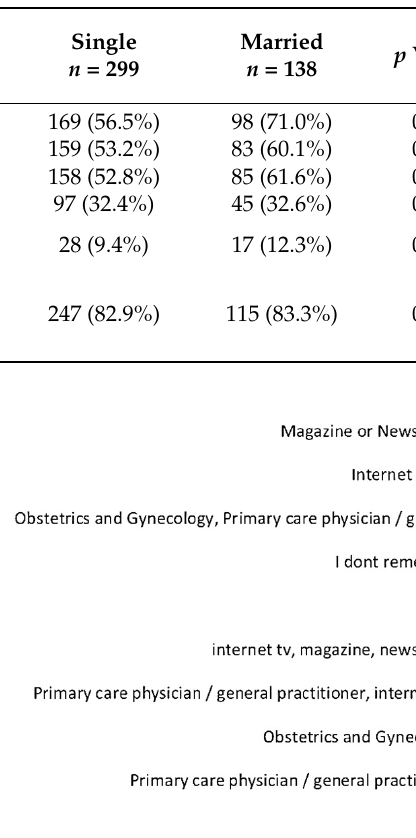
Table 4. Proportion of responses to knowledge and awareness questions across marital status and having children.